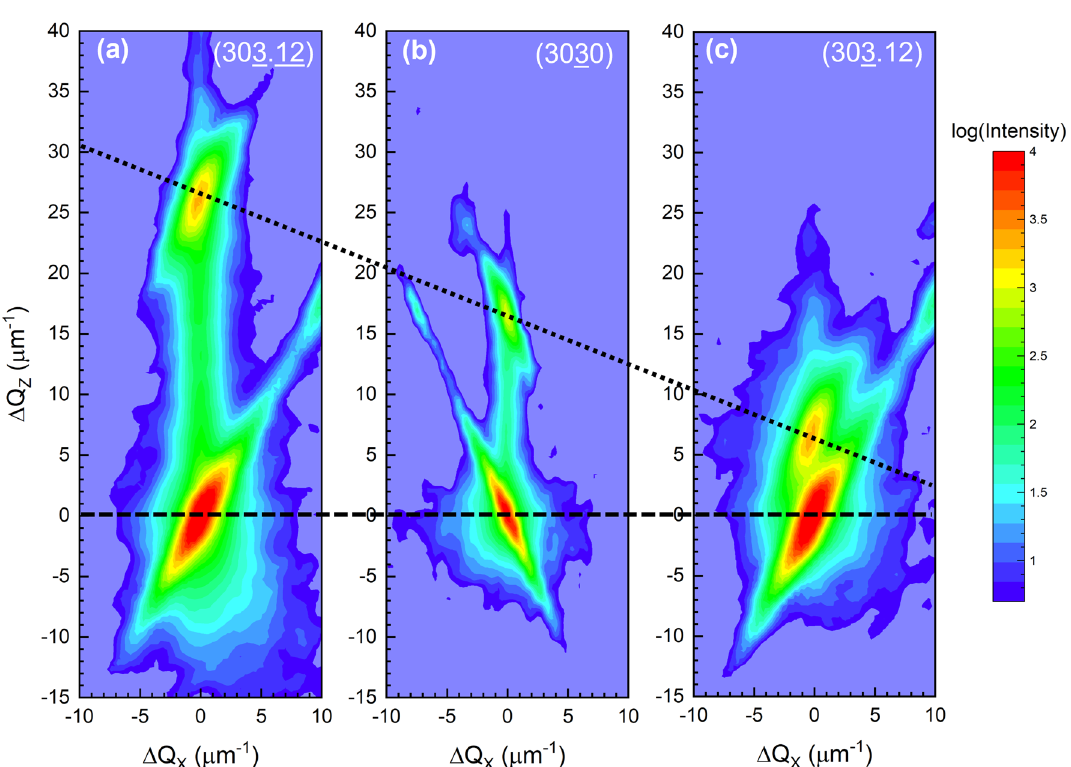
Figure 5. Reciprocal space maps for the ( a ) asymmetric 303.12 ( b ) symmetric 3030, and ( c ) asymmetric 303.12 reflection. The upper peaks in each RSM correspond to the strained implanted calcite layer while the lower peaks correspond to the substrate. Q X and Q Z correspond to the [0001]* and [1010]* directions, respectively. The horizontal dashed line corresponds to the substrate peaks, while the diagonal dotted line corresponds to the strained layer peaks. The non-vertical streaks observed at both the substrate and strained layer peaks are due to the incident and scattered beam optical elements of the X-ray diffractometer. Both 303.12 and 303.12 RSMs were measured in the glancing exit geometry, where 303.12 was measured such that the sample was rotated in-plane 180° with respect to the 3030 and 303.12 RSMs 28